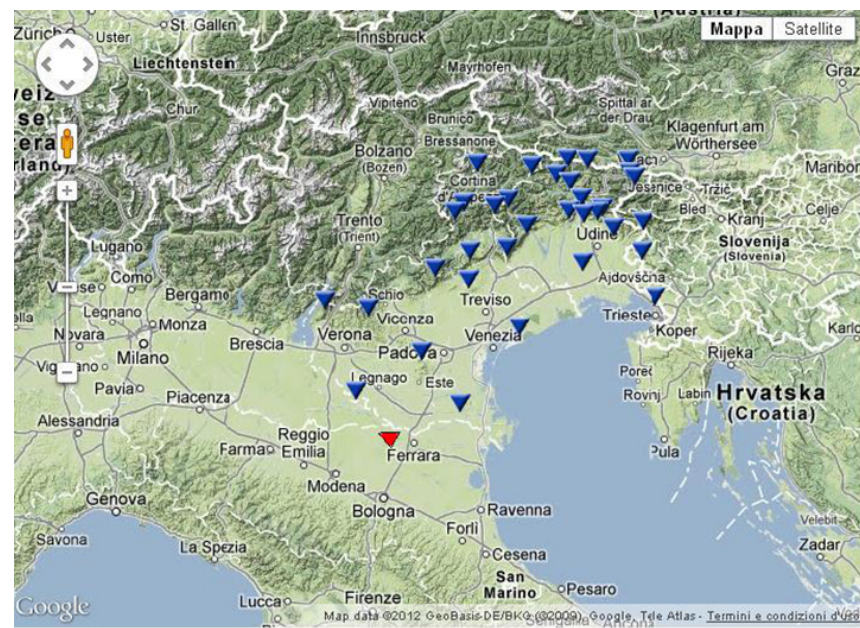
Figure 1. The North-eastern Italy Seismic Network (NI) run by OGS with the Ferrara borehole site in